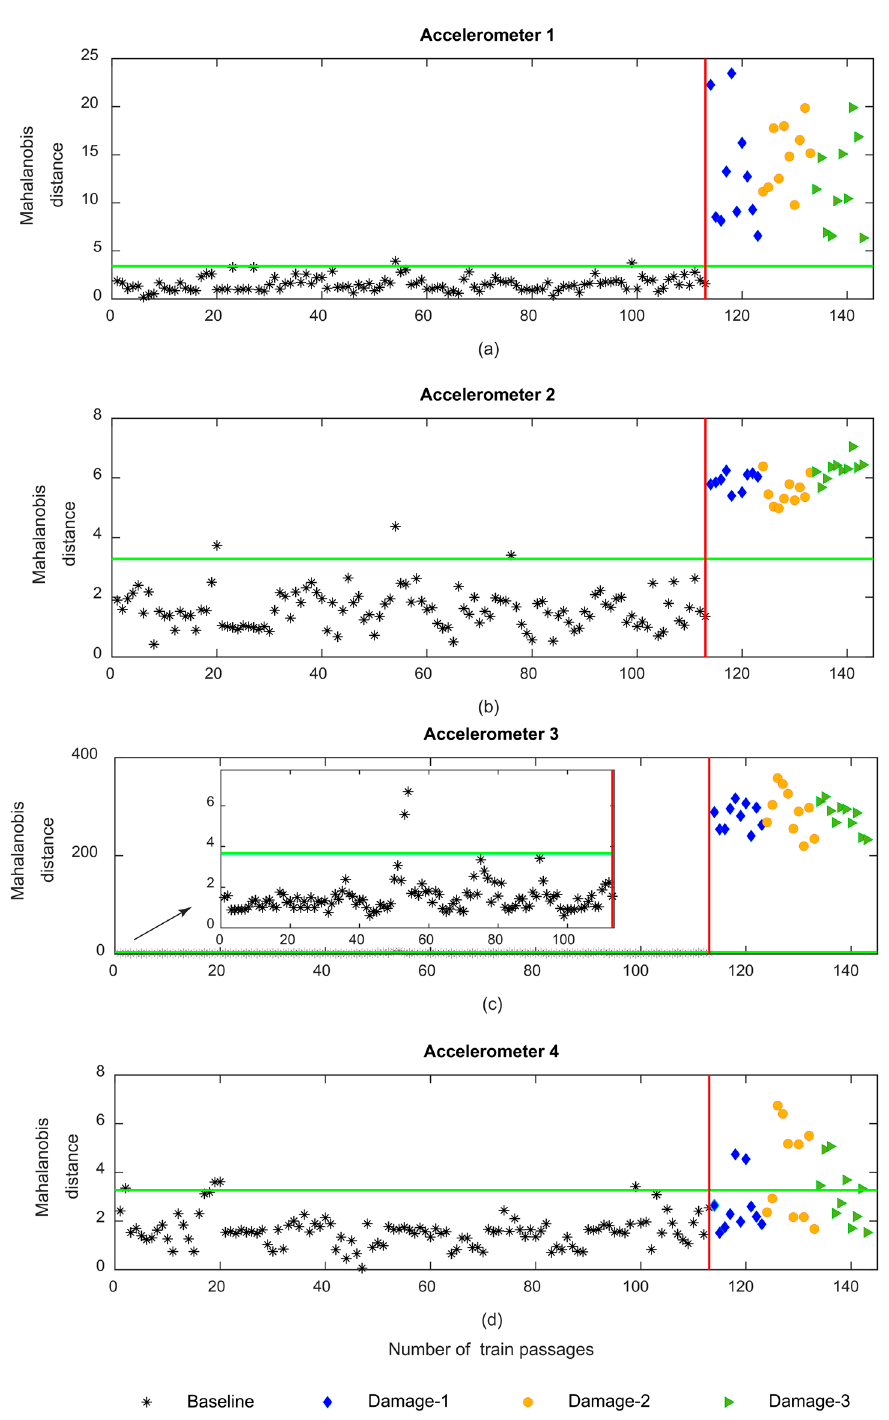
Figure 23. PCA—automatic wheel flat damage detection considering the responses from accelerom- eters 1–4: ( a ) MD for accelerometer 1, ( b ) MD for accelerometer 2, ( c ) MD for accelerometer 3, ( d ) MD for accelerometer 4.